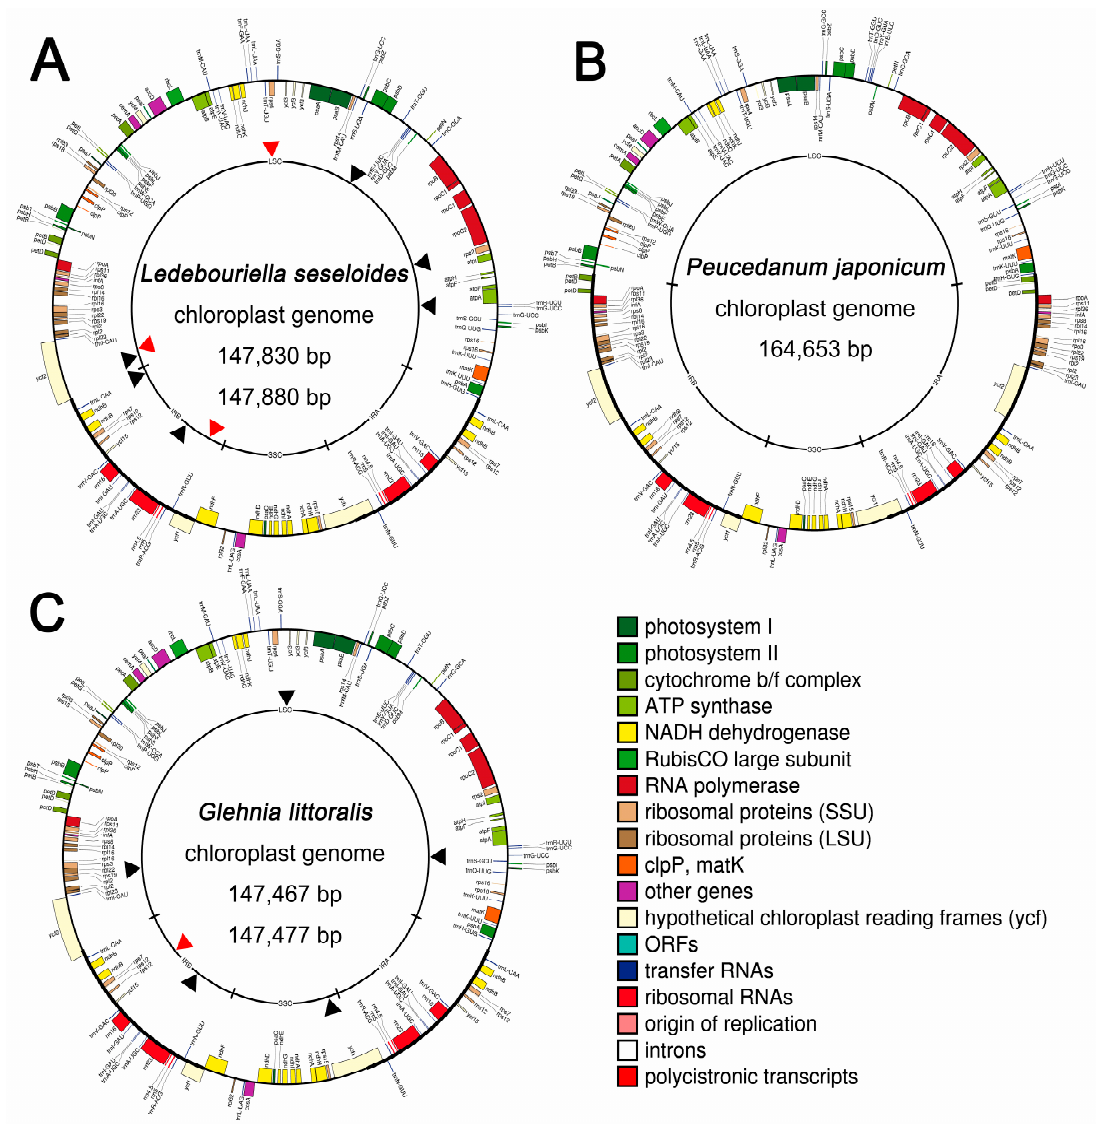
Figure 1. Chloroplast (cp) genome maps of Ledebouriella seseloides ( A ), Peucedanum japonicum ( B ), and Glehnia littoralis ( C ). Colored boxes are conserved cp genes, annotated using the DOGMA program, with manual editing based on BLAST searches. Maps were generated using OGDraw. Genes transcribed clockwise and counterclockwise are indicated on the outside and inside of the large circle, respectively. The intraspecies polymorphic sites 9, 0, and 6 are indicated by black arrowheads for indels and red arrowheads for SNPs in the inner circles of A and C.